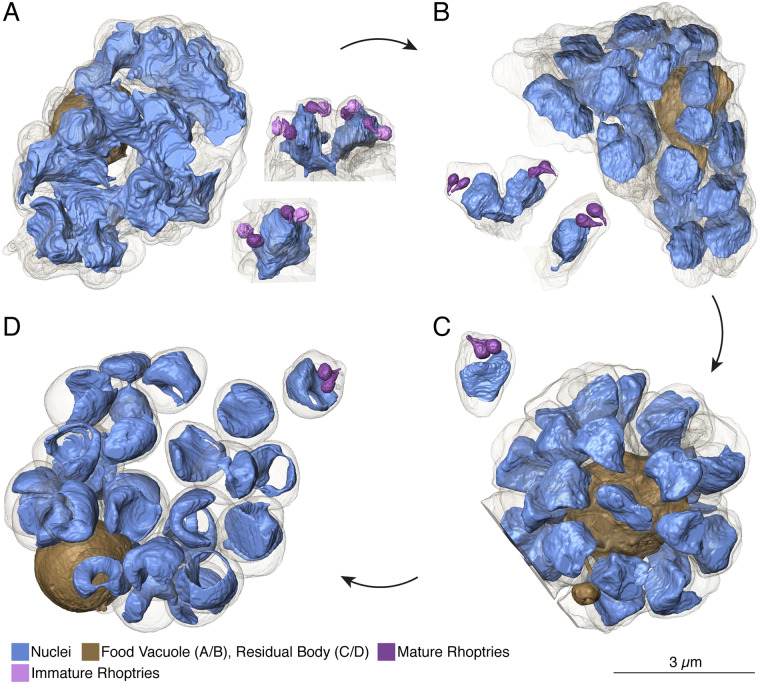
Nuclear architecture throughout segmentation.A. In early segmentation, nuclei appear jagged and are associated with two (in 11 of 13) or four (in 2 of 13) sets of rhoptries. The mature rhoptry from each pair is in close association with the nucleus. B. In mid-segmentation, nuclei have a smoother appearance, and of fully rendered nuclei, five are 2n and 13 are 1n. Half of imaged rhoptry sets retain a nuclear association. C. By PVM rupture, all nuclei are separated into their respective merozoites. No rhoptry sets have a visible nuclear association. D. Post-PVM rupture, nuclei have depressed centers, forming a toroid shape or C-shape. We note that this may be due to prolonged RBC entrapment with E64. One daughter cell was ruptured in sample preparation, resulting in two lobes of bridged DNA (seen near the top of the cell). In A and B, the food vacuole is rendered, in C and D, the residual body, containing the food vacuole and residual cytoplasmic material, is rendered. Scale bars of renderings interpolated from structure sizes in EM data.